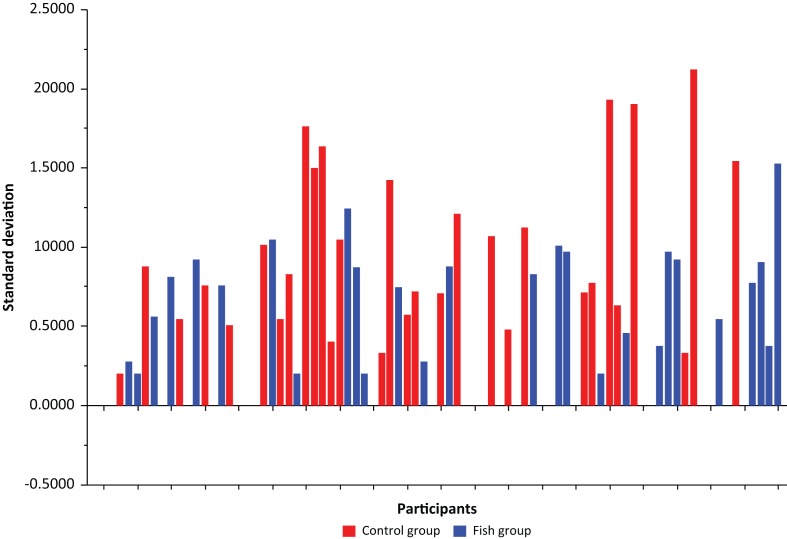
Standard deviation of the weekly physical activity. Red bars indicate the Control groups, blue bars indicate the Fish group.